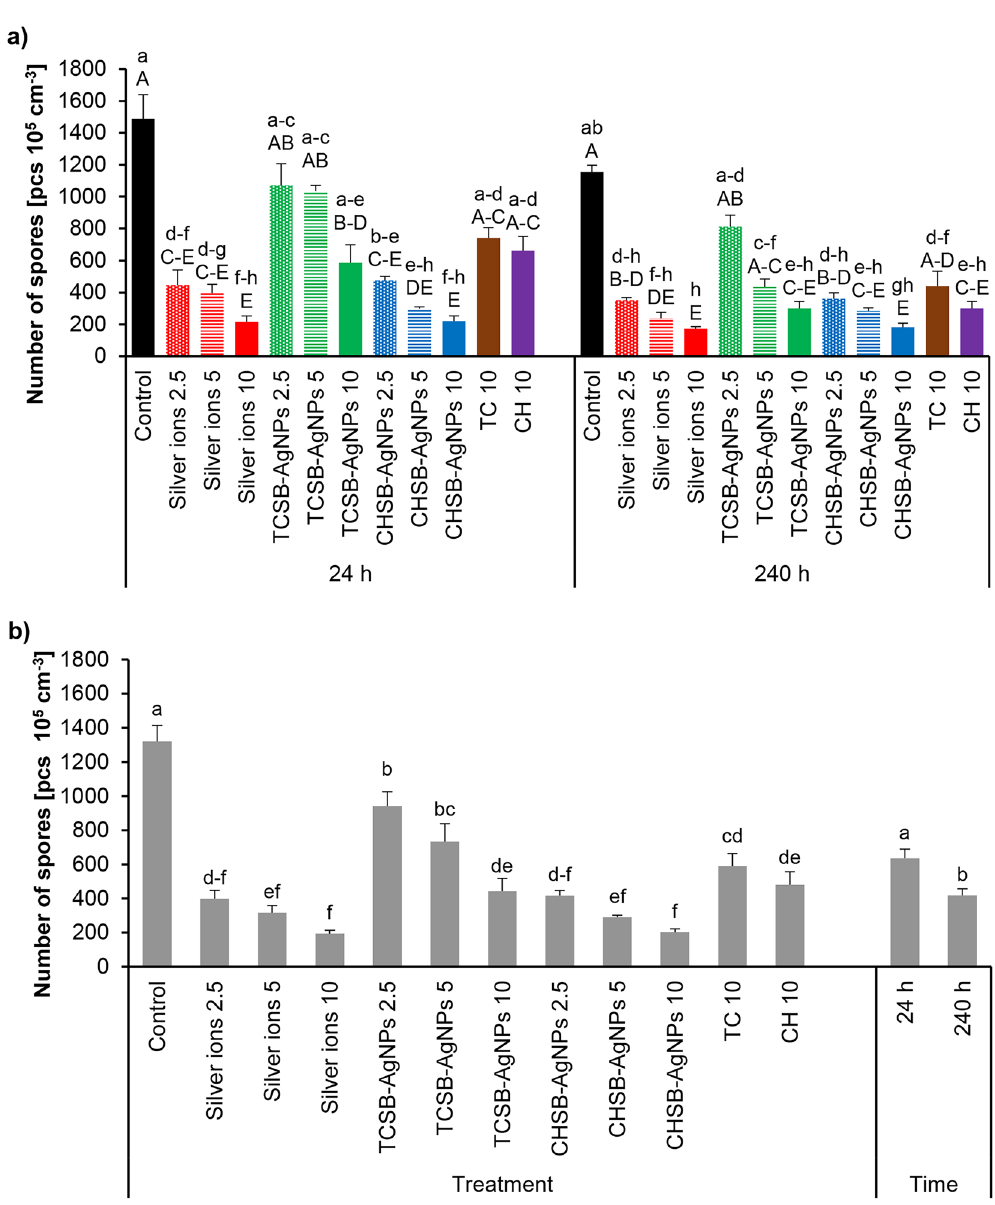
consisted of 2 subgroups. The first subgroup consisted of CHSB-AgNPs and silver ions at the lowest concentra- tion (24 h), TCSB-AgNPs at a concentration of 5 mg L −1 (240 h), TC (240 h) and silver ions at concentrations of 2.5 (240 h) and 5 mg L −1 (24 h), and CHSB-AgNPs at a concentration of 2.5 mg L −1 (240 h). The second subgroup included CHSB-AgNPs at the concentrations of 5 mg L −1 (24 and 240 h) and 10 mg L −1 (24 and 240 h), and TCSB-AgNPs at the highest concentration (240 h), CH (240 h) and silver ions at the concentrations of 5 mg L −1 (240 h) and 10 mg L −1 (24 and 240 h). The second group consisted of a first subgroup with little differentiation— silver ions at the highest concentration (240 h) and the second, more extensive subgroup. The second subgroup consisted of TC at the concentration of 10 mg L −1 (240 h), TCSB-AgNPs at the concentrations of 2.5 mg L −1 (24 and 240 h), 5 and 10 mg L −1 (24 h), CH at the concentration of 10 mg L −1 (24 h), and the controls (24 and 240 h). The PCA biplot for the interaction between the compounds and the tested fungal parameters is shown separately for each treatment time (24 h and 240 h) in Fig. 8b. In each case, the first two factors (F1 and F2)